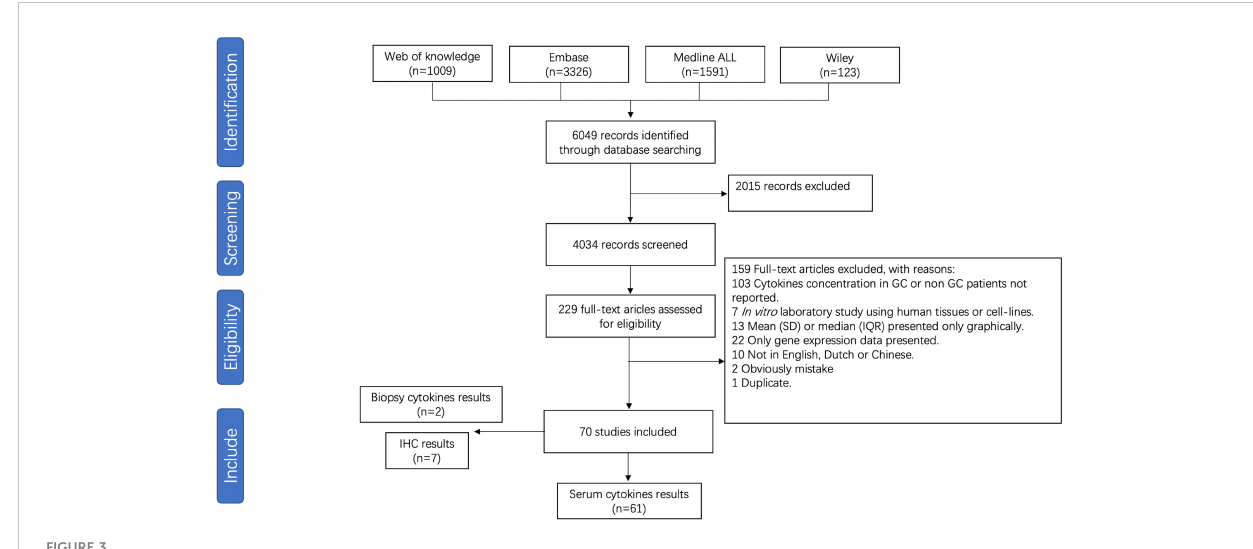
FIGURE 3 Flow chart of study selection for gastric cancer meta-analysis.